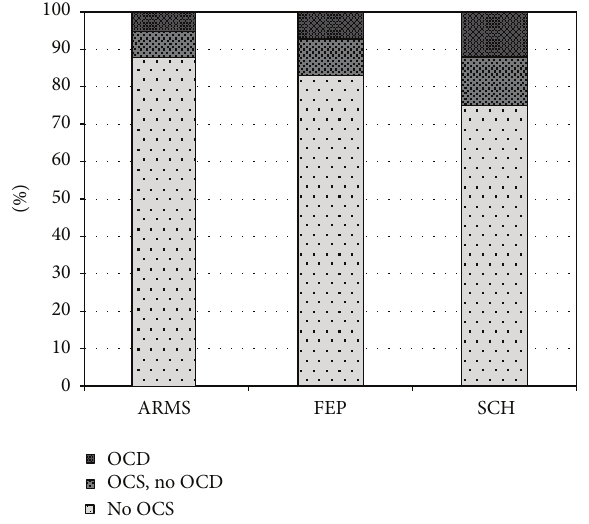
Figure 1: Estimations on prevalence of OCS and OCD according to different samples of patients. (1) Mean prevalence rates in at-risk mental state studies (ARMS). (2) Mean prevalence rates in first episode psychotic patients. (3) Mean prevalence rates in schizophrenia